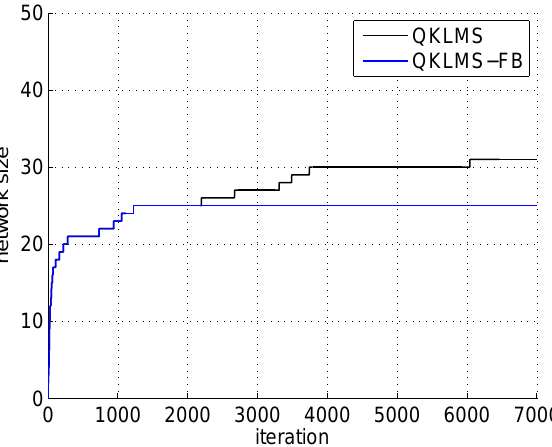
Figure 10. The network size growth curves of the QKLMS and QKLMS-FB algorithms in time-varying channel